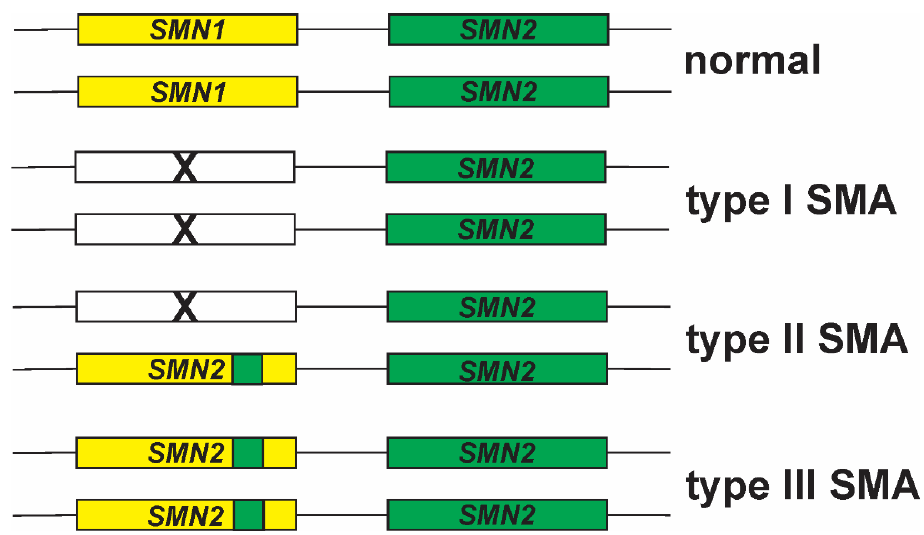
Figure 2. Relationship between SMN1 – SMN2 gene conversion and disease severity in SMA. Adapted from [134].